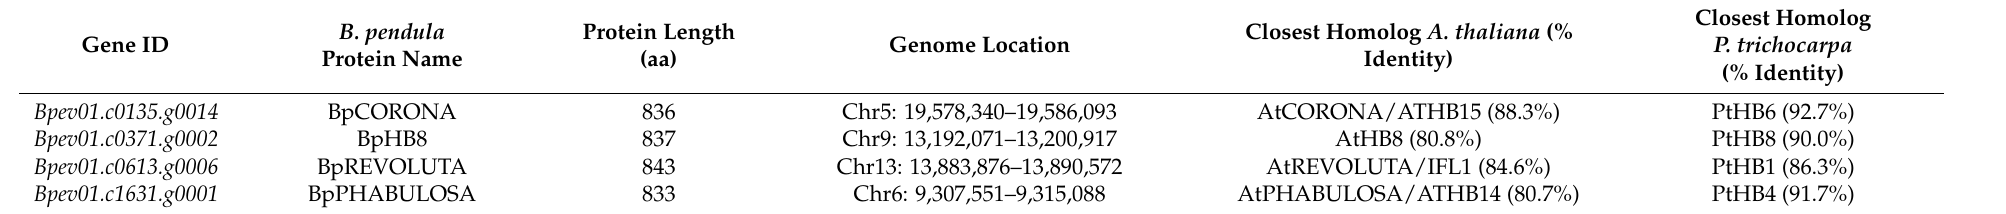
Table 3. Characteristics of HD ZIP III members in